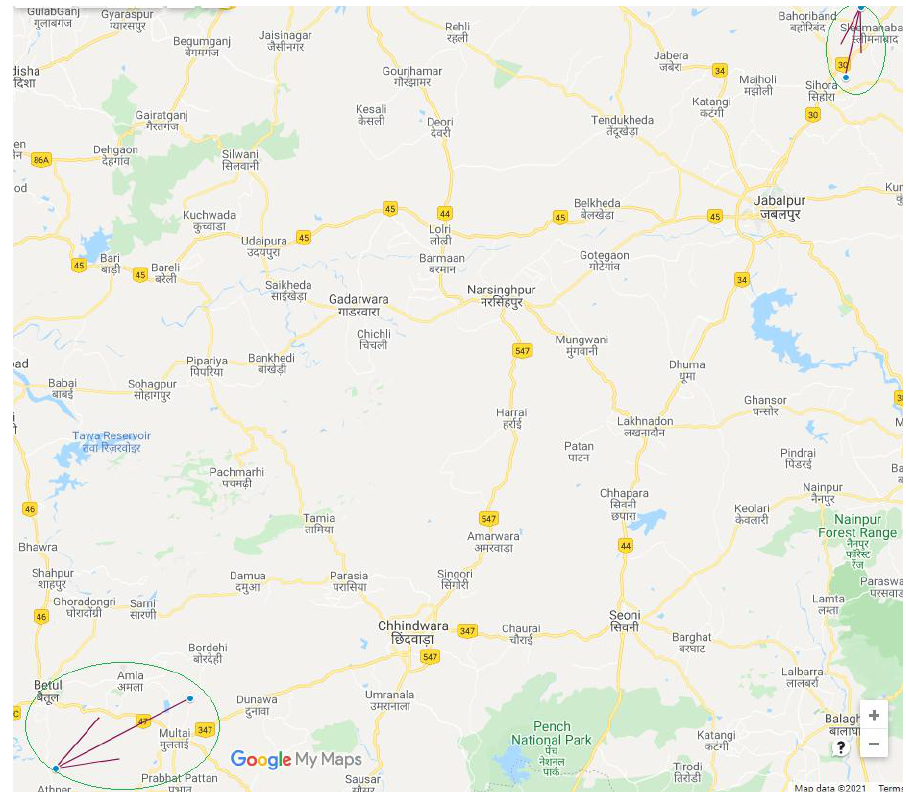
Figure 3 Movements of Population and Economic Centres in India (Enlarged